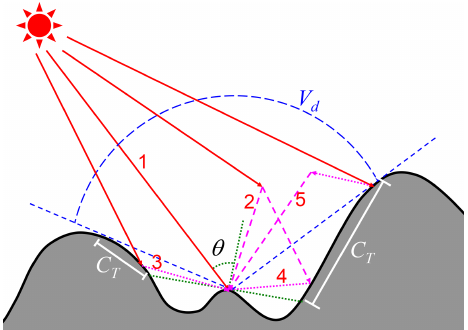
Figure 1. A schematic diagram of the five components of incoming solar radiation over mountains adapted from Lee et al. (2011). The components of incoming solar radiation included are (1) direct flux, (2) diffuse flux, (3) direct-reflected flux, (4) diffuse-reflected flux, and (5) coupled flux. Local solar zenith angle ( θ ), sky view factor ( V d ), and terrain configuration factor ( C T ) are also